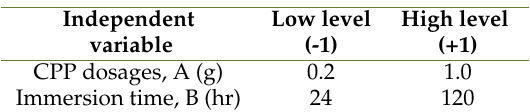
Table 1. Experimental design ranges of independent variables for CPP inhibitor.